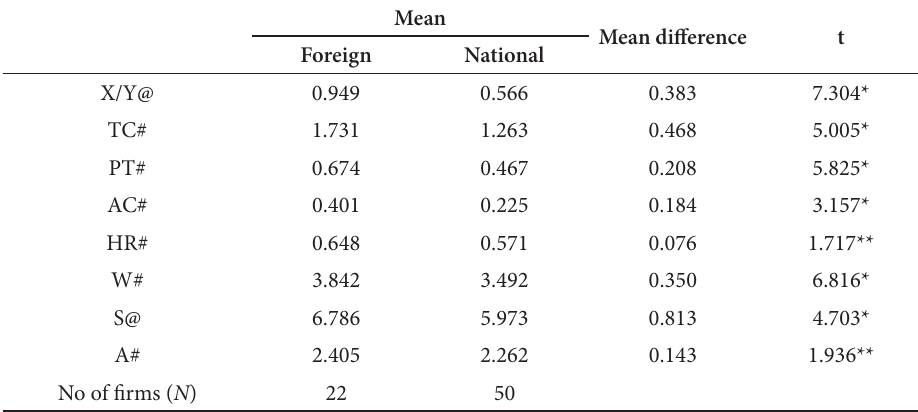
Table 4. Two tailed t-tests of critical variables, Garment firms, Myanmar,